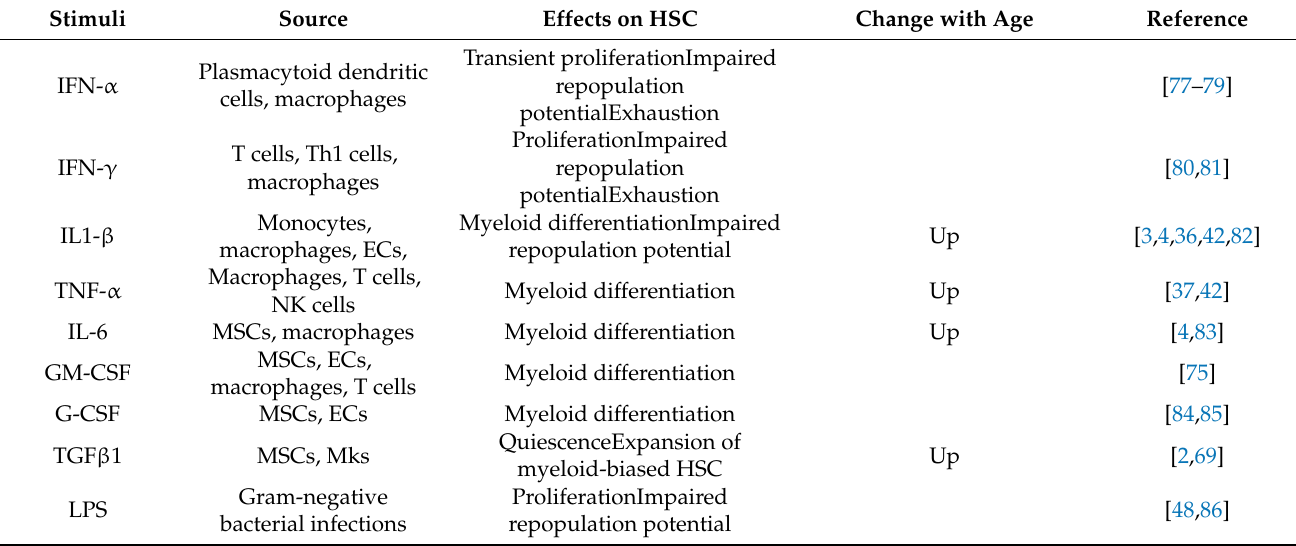
Table 2. The role of pro-inflammatory cytokines in hematopoiesis and their altered expression during aging.